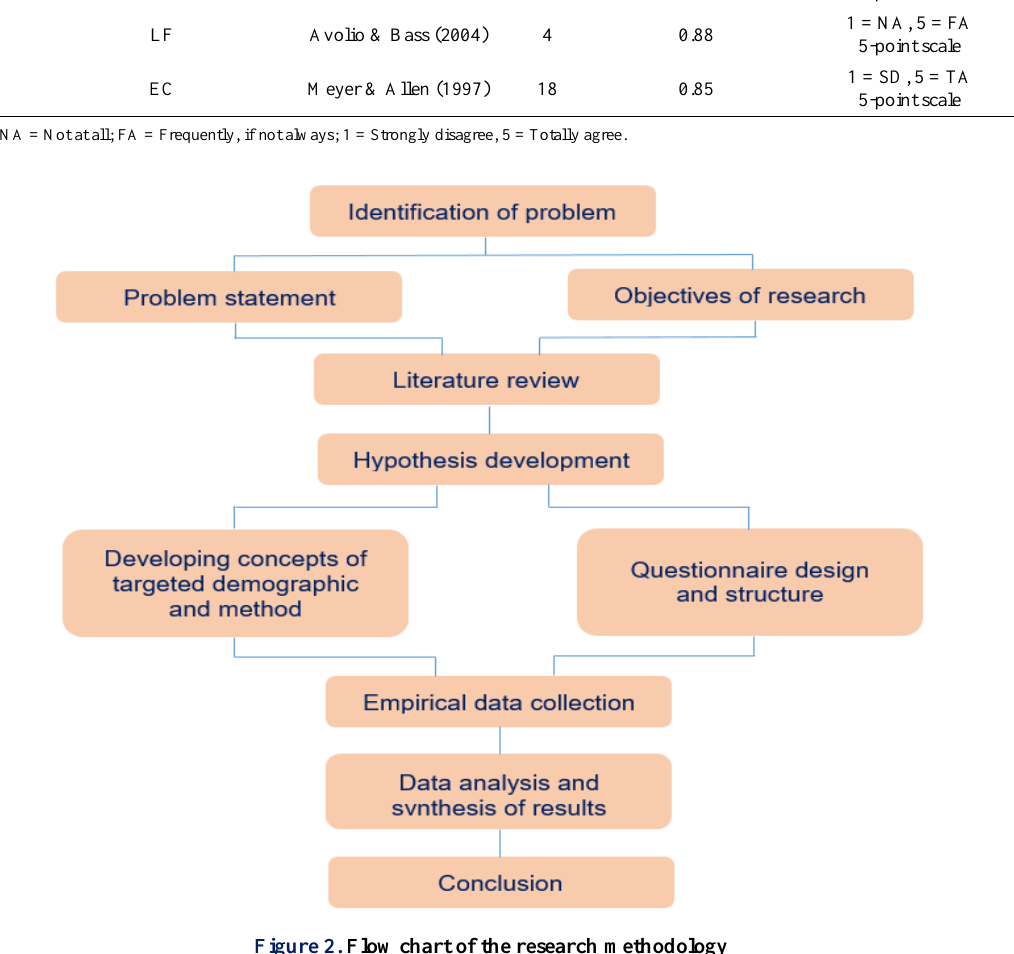
Figure 2. Flow chart of the research